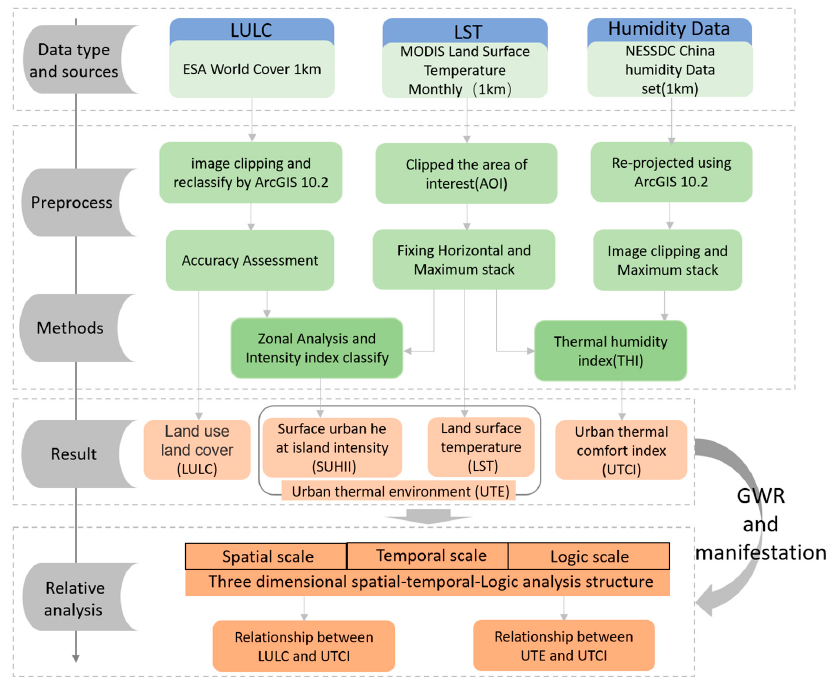
Figure 2. Technology road map.